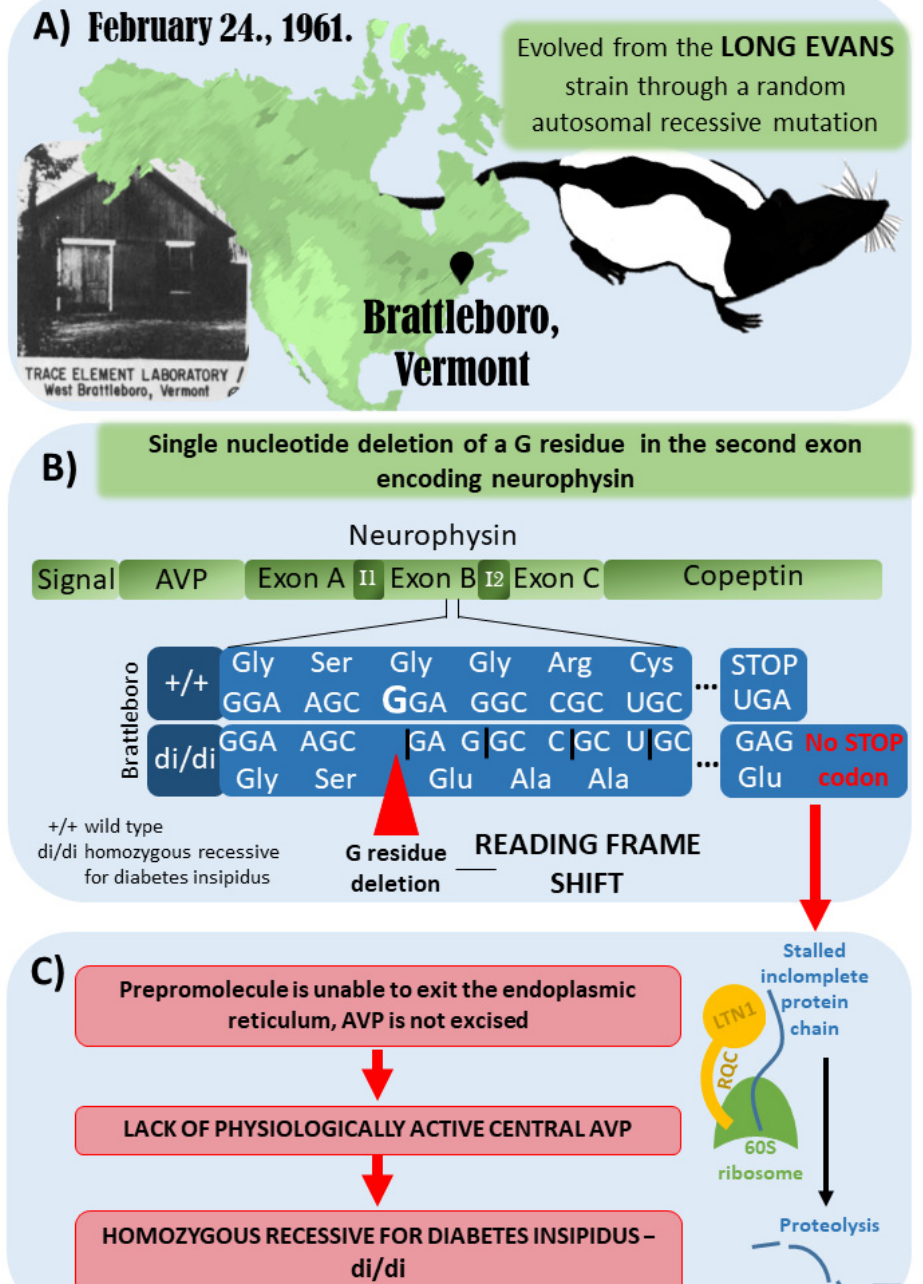
Figure 2. Development of the Brattleboro rat strain. ( A ) Brattleboro rat strain was discovered in 1961 in Brattleboro, Vermont. It evolved from the Long–Evans rat strain through a random autosomal recessive mutation. ( B ) The genetic mutation of Brattleboro strain is a single nucleotide deletion of a G residue in the second exon of neurophysin gene. Due to this mutation, a reading frame shift develops, which results in different C-terminus for the precursor hormone. ( C ) Due to the lack of stop codon, the mRNA cannot leave the ribosomes after translation, and the incomplete protein-chain might also stall in the ribosome. Therefore, a ubiquitin ligase (LTN1), which is part of the ribosome-associated quality control complex, will induce proteolysis. All in all, vasopressin (AVP) is missing; thus, there is no physiologically active central AVP, leading to central diabetes insipidus with polydipsia and polyuria [41–45] .